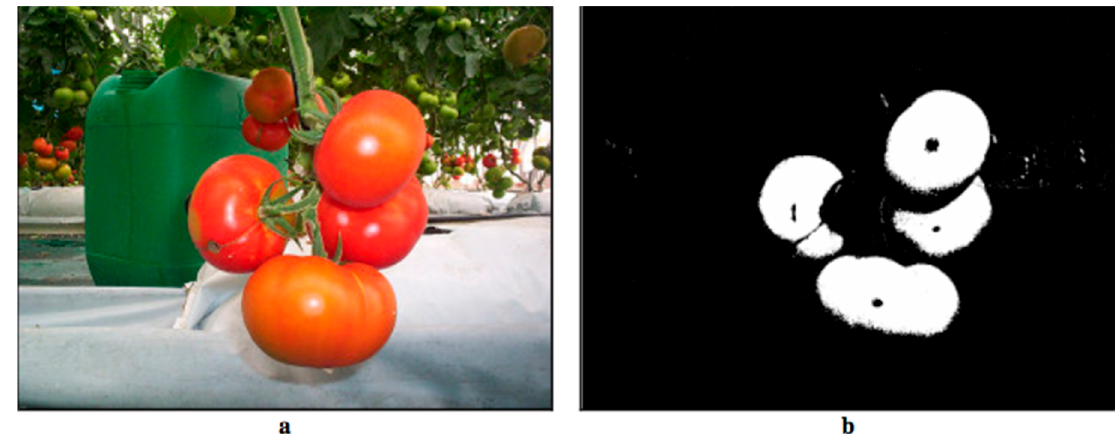
Figure 11. ( a ) Original image; and ( b ) color-based segmentation 2 (obtaining separated regions).